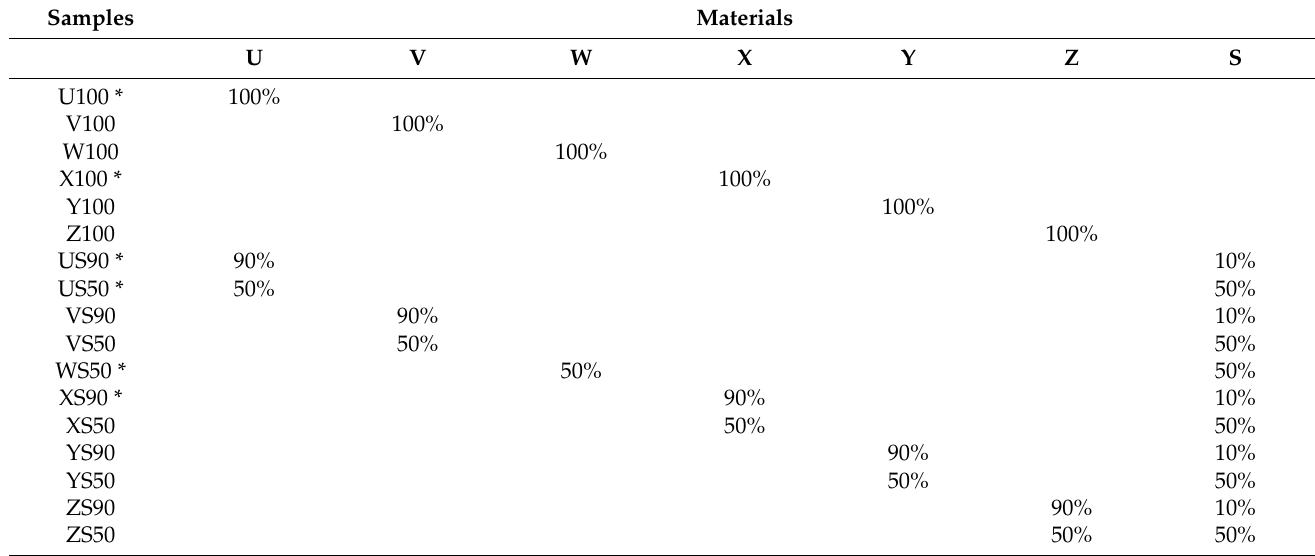
Table 3. Sample preparation for the additional Kenyan chia oil samples (U–Z) that were adulterated with sunflower oil (S). Samples indicated with * were prepared only once, the others were prepared two times.